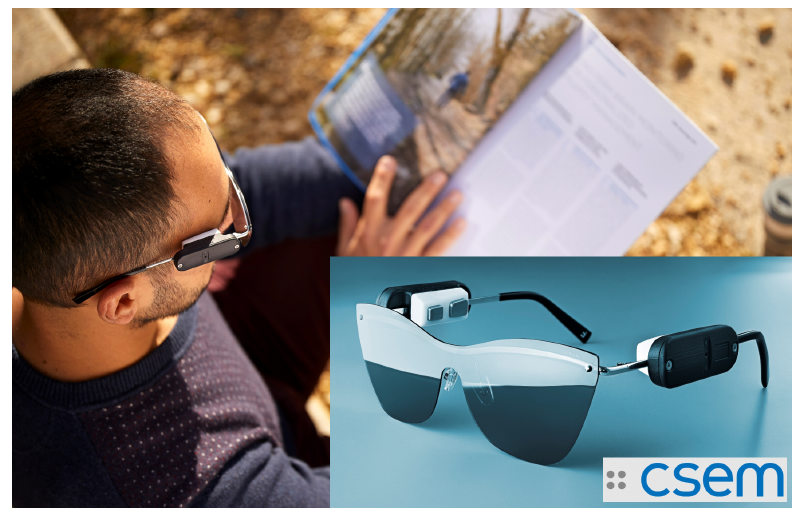
Figure 4. The ULTEEM recording system developed by CSEM (Swiss center for electronics and microtechnolgy) is integrated into glasses and thus minimizes obtrusiveness and